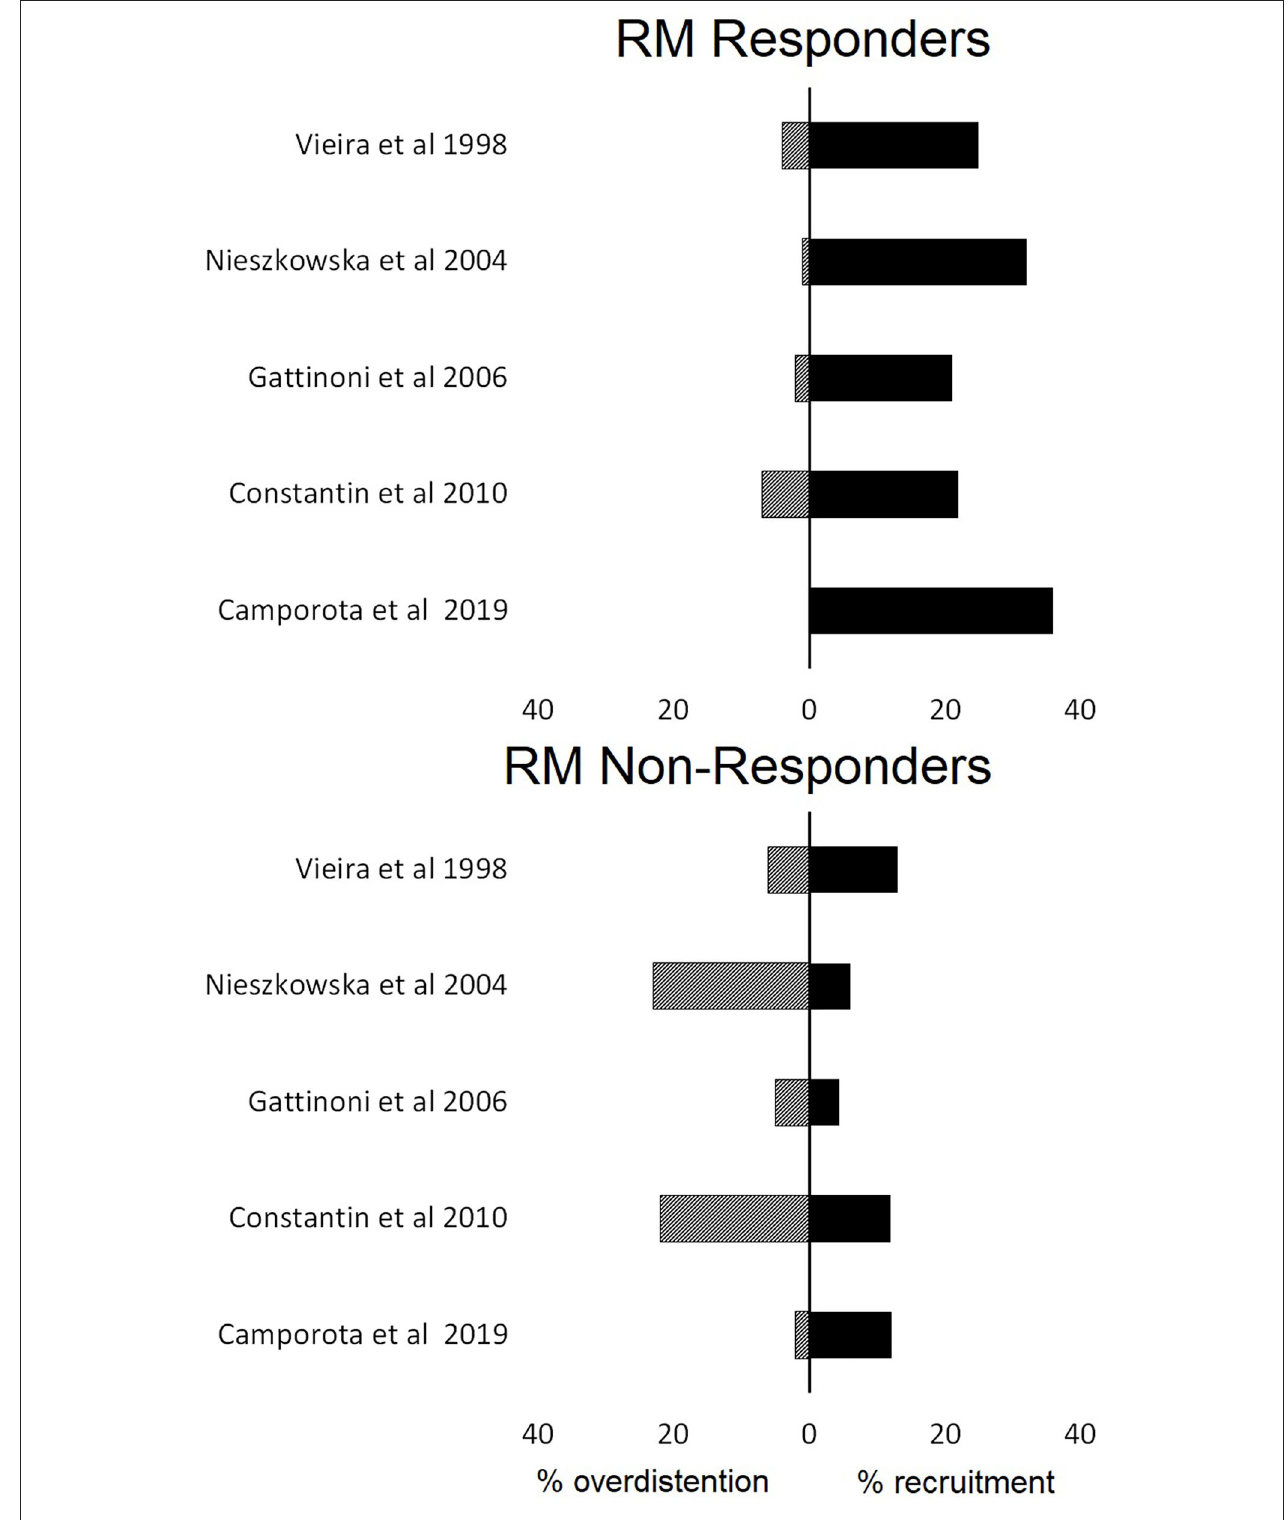
FIGURE 2 | The proportions of lung recruitment and lung overdistention in patients who were characterized responders or not responders to lung recruitment maneuvers (RM) based on computed tomography findings.